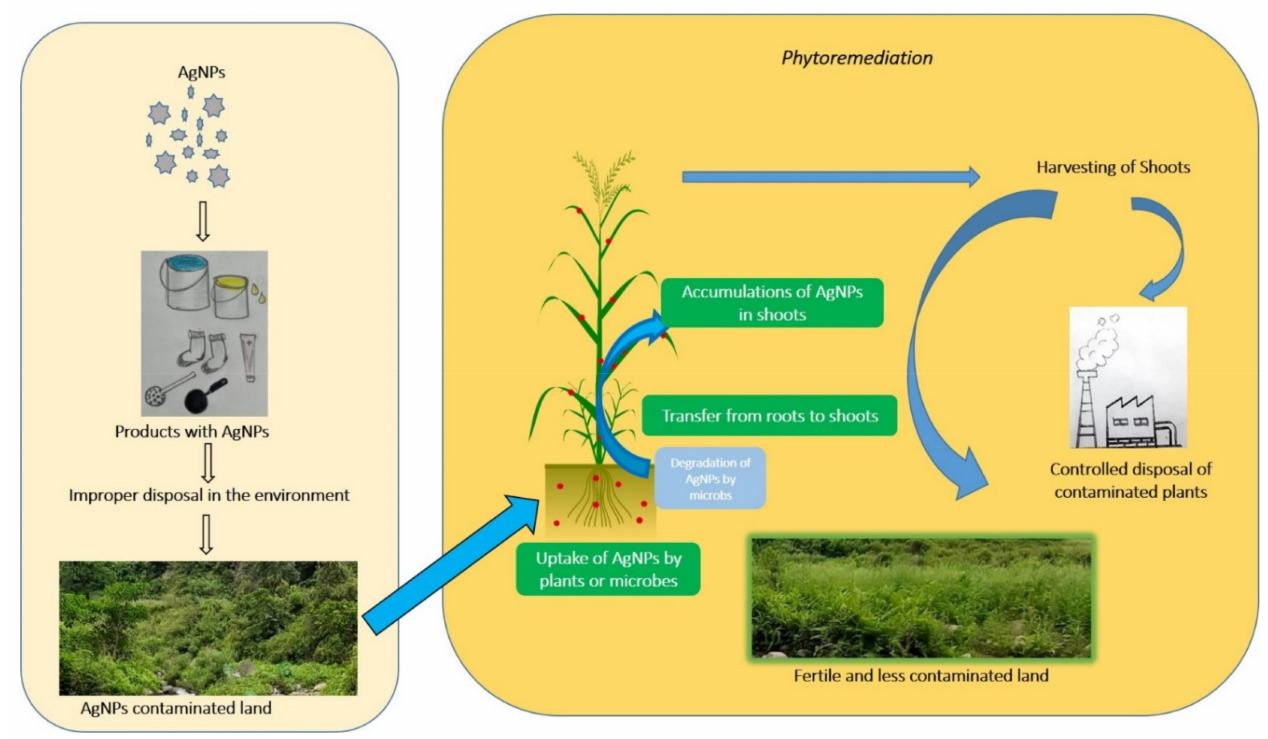
Figure 1. Potential pathway for AgNPs leakage into the environment and its